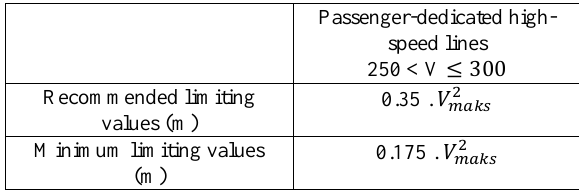
Table 4 Limit values of vertical curve radius (CEN, 2010)